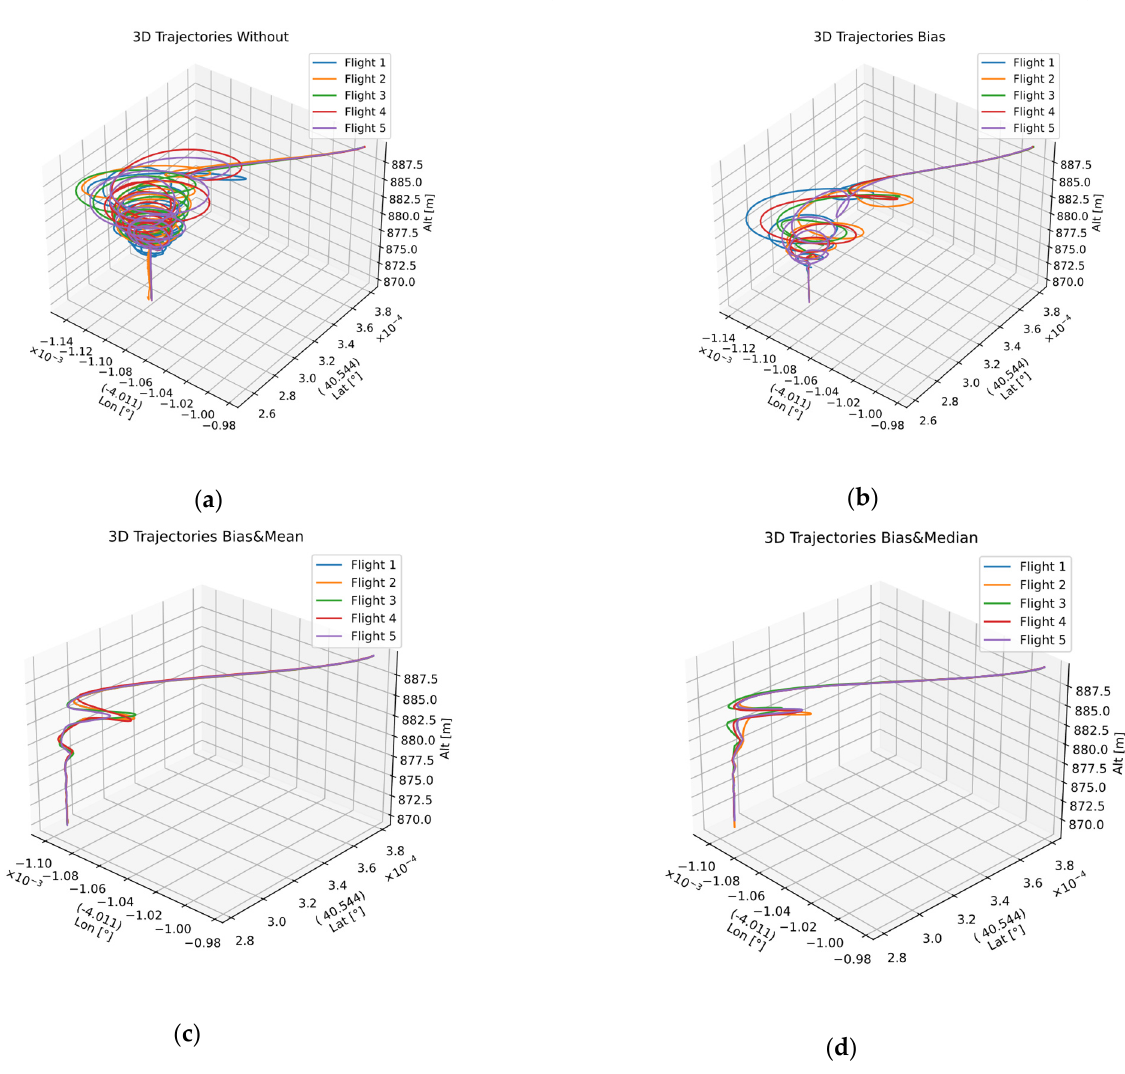
Figure 14. Five-flight 3D graphics for each of the four groups: ( a ) without correction; ( b ) bias correction; ( c ) bias and mean filter; ( d ) bias correction and median filter.